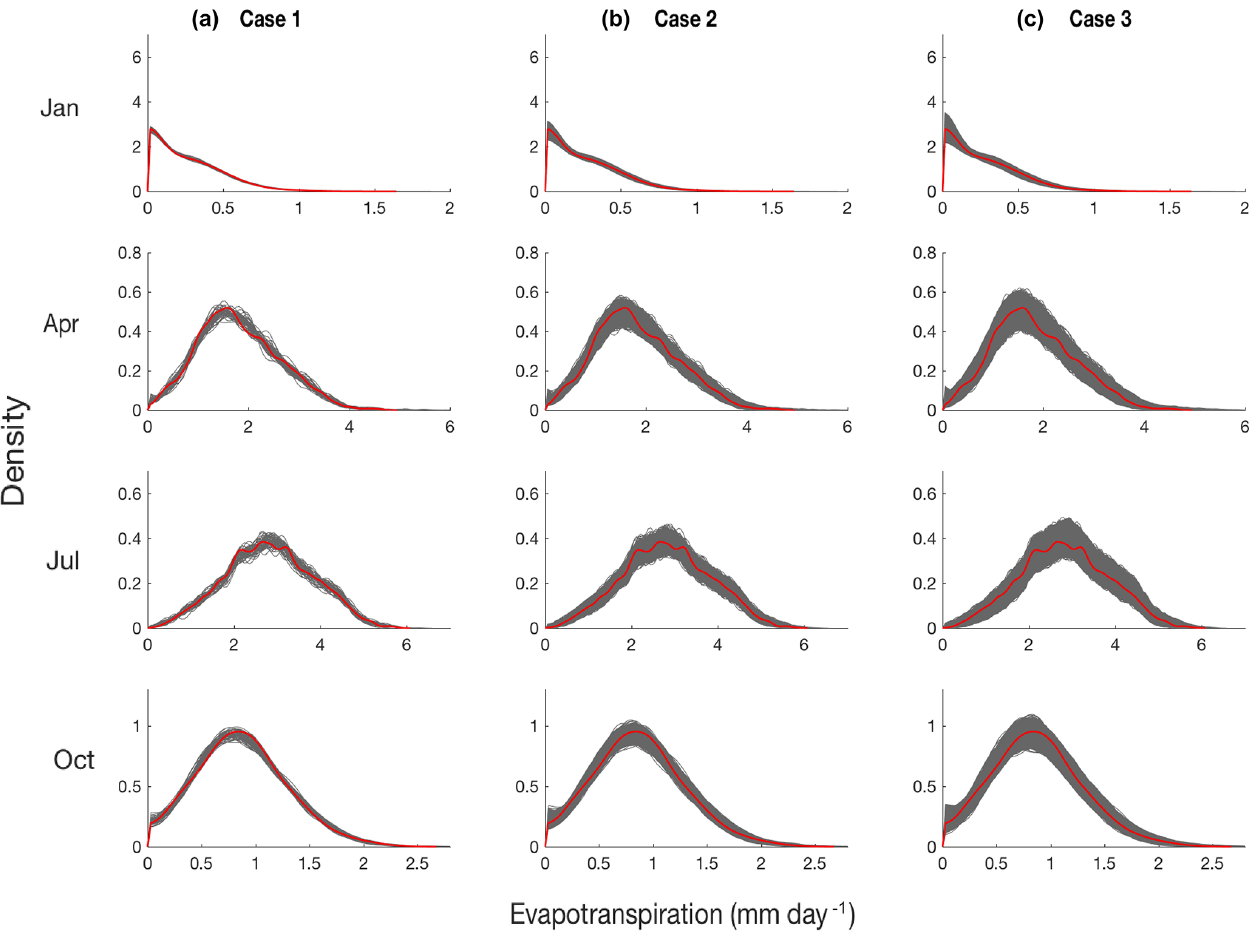
Figure 14. Comparison between the probability density functions of observed evapotranspiration time series (red) and the ensemble of sim- ulated time series of evapotranspiration (grey) using the C-vine copula V TPE in case 1 (a) , on the basis of observed precipitation and simulated temperature in case 2 (b) and on the basis of simulated precipitation and temperature in case 3 (c)